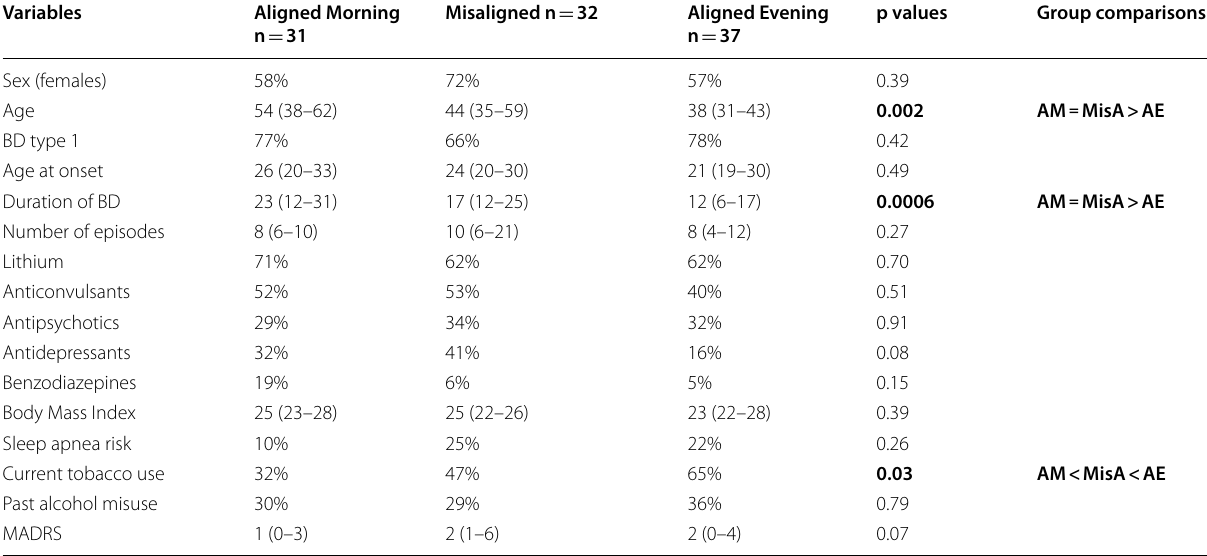
Categorical variables are reported as percentage. Continuous variables are reported as median and interquartile